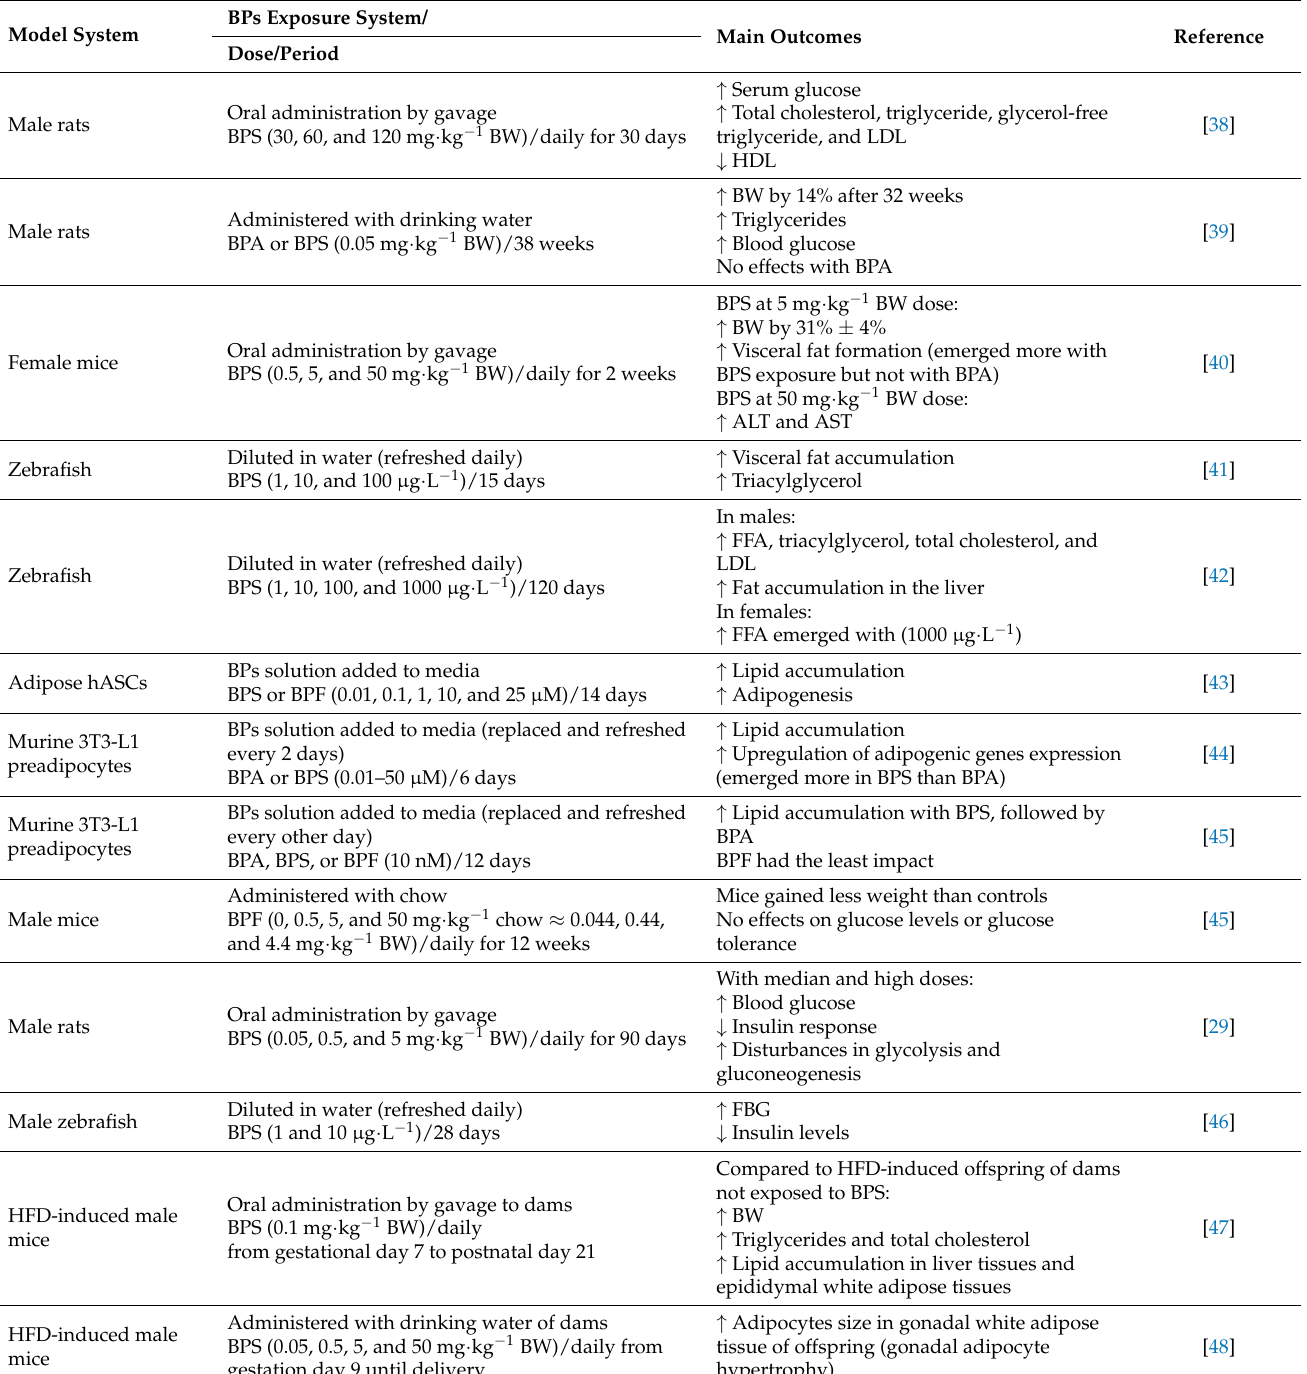
Table 2. Summary of in vivo and in vitro studies reporting the obesogenic and diabetic effects of BPS and BPF